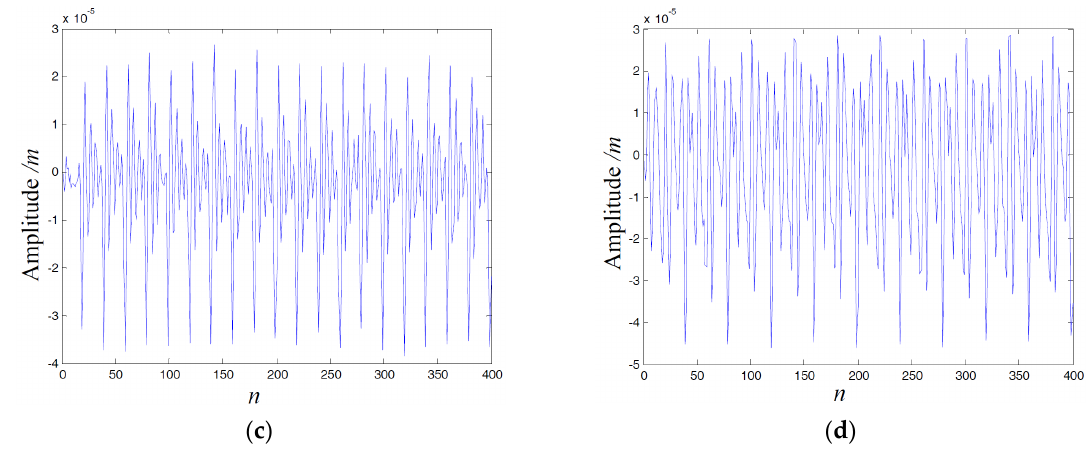
Figure 7. Simulation signals by adding noises (Signal ‐ to ‐ noise ratio (SNR) = 97). ( a ) Unbalance; ( b ) misalignment; ( c ) rub ‐ impact; ( d ) the combination of rub ‐ impact and unbalance. Table 2. The calculation results in each frequency band of each fault. The Calculated Results in 8 Frequency Bands of Unbalance